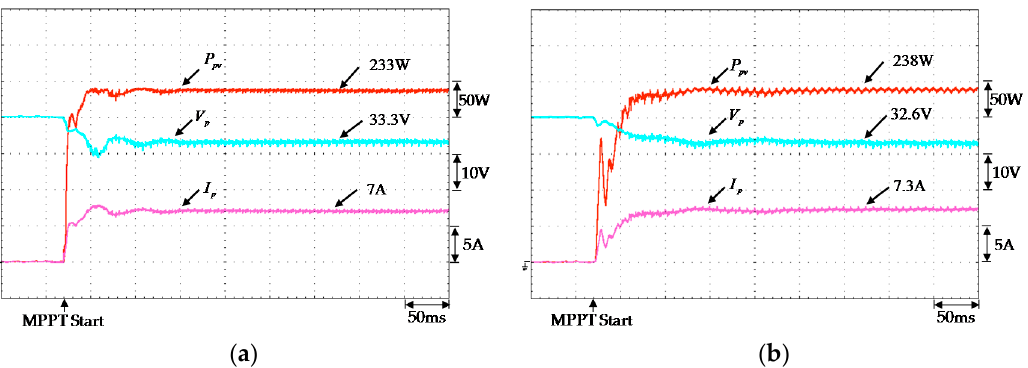
Figure 13. Performance comparison between MPPT algorithms: ( a ) P & O MPPT; ( b ) Improved INC MPPT.